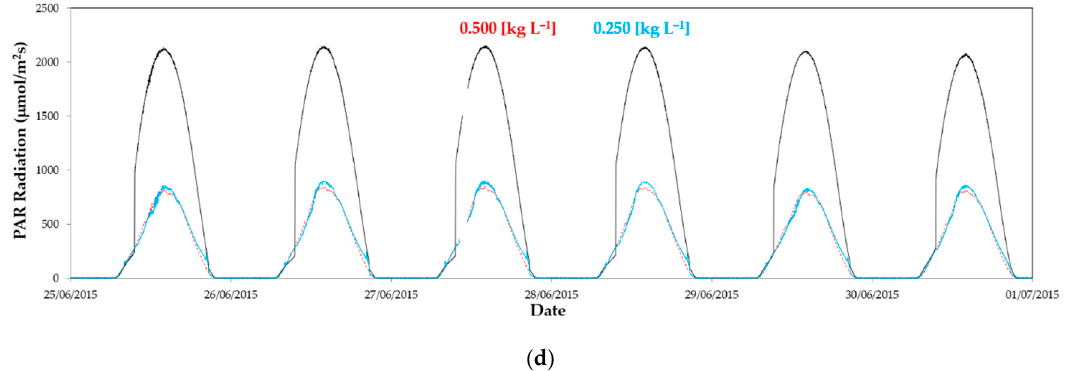
Figure 3. Evolution of photosynthetically active radiation (PAR) outside (—-) and inside greenhouse 1 in the east sector ( ····· ) and west sector (—-): ( a ) From 1 to 5 February2015 without whitening in both sectors; ( b ) from 28 March 2015 to 3 April 2015 with a concentration of 0.125 kg L − 1 in the east and 0.250 kg L − 1 in the west; ( c ) from 16 to 22 June 2015 with a concentration of 0.250 kg L − 1 in both sectors; ( d ) from 25 June 2015 to 1 July 2015 with a concentration of 0.500 kg L − 1 in the east and 0.250 kg L − 1 in the west.